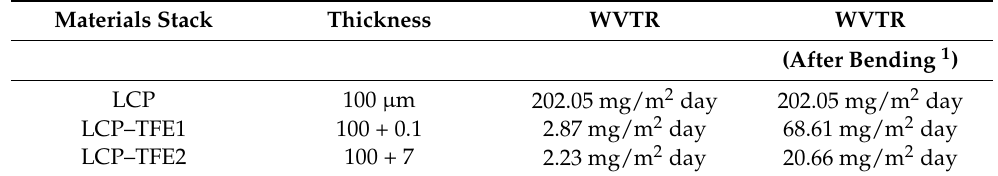
Table 1. WVTR of the coatings measured with a Sorption Analyser at 60 °C and 60% relative hu- midity.